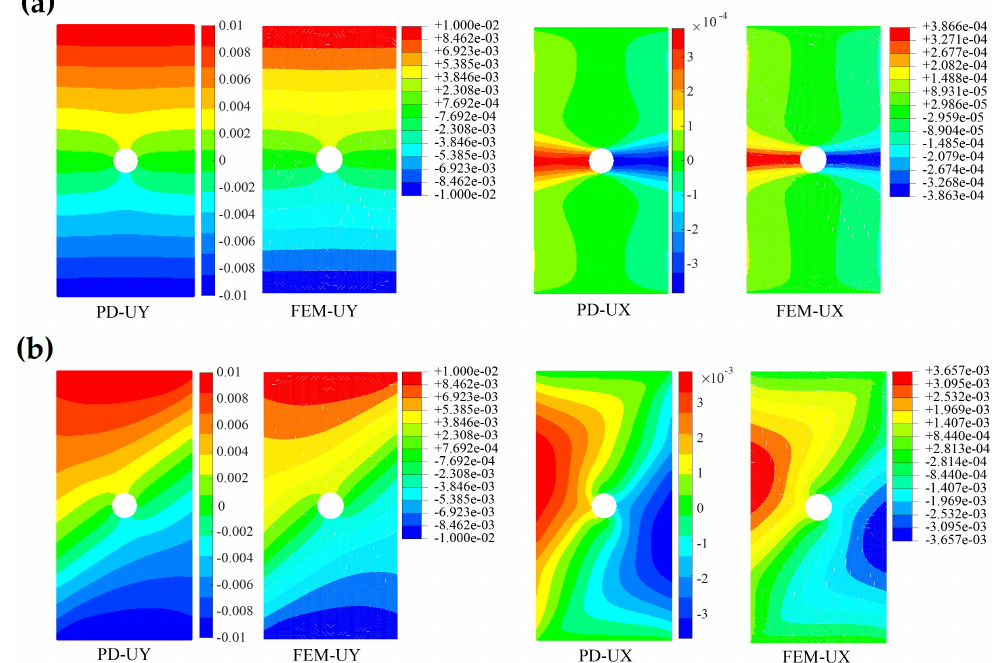
Figure 6. Displacement fields of laminas with different fiber directions. ( a ) Comparison of the displacement fields of 0 ◦ open-hole lamina under tensile loading (mm). ( b ) Comparison of the displacement fields of 45 ◦ open-hole lamina under tensile loading (mm).